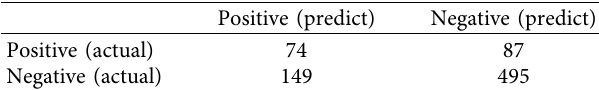
Table 6: Low precision data set confusion matrix.